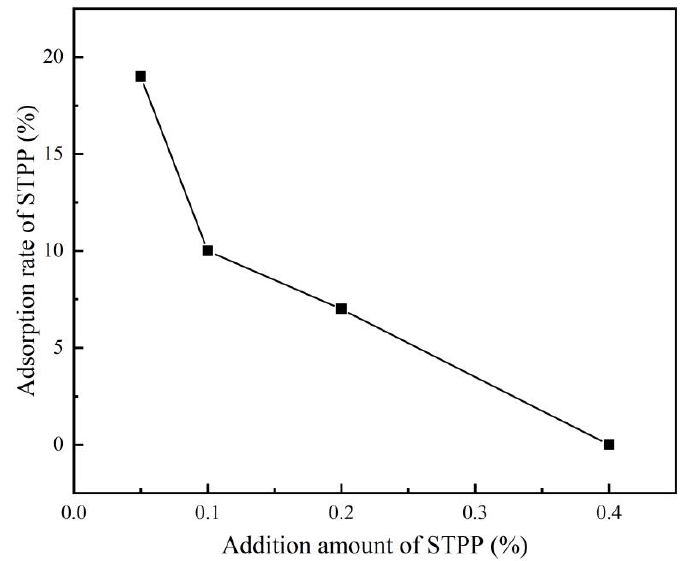
Figure 2. Adsorption rate of STPP after 10 min of stirring, as a function of the addition amount of STPP.